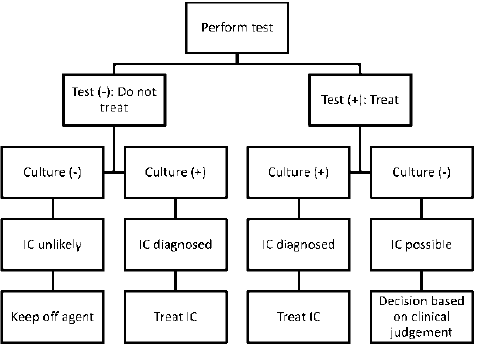
Figure 1. Paradigm for incorporating non-culture tests into antifungal treatment strategies against invasive candidiasis (IC). The paradigm can be applied to pre-emptive or prophylactic antifungal strategies. Treatment decisions are made at two stages, in response to non-culture test results and non-culture results combined with blood cultures, respectively. The viability of the paradigm depends upon positive and negative predictive values (PPVs and NPVs) at each stage. By applying data from Table 2, clinical settings in which non-culture test-driven strategies are likely to be useful can be identified (Table